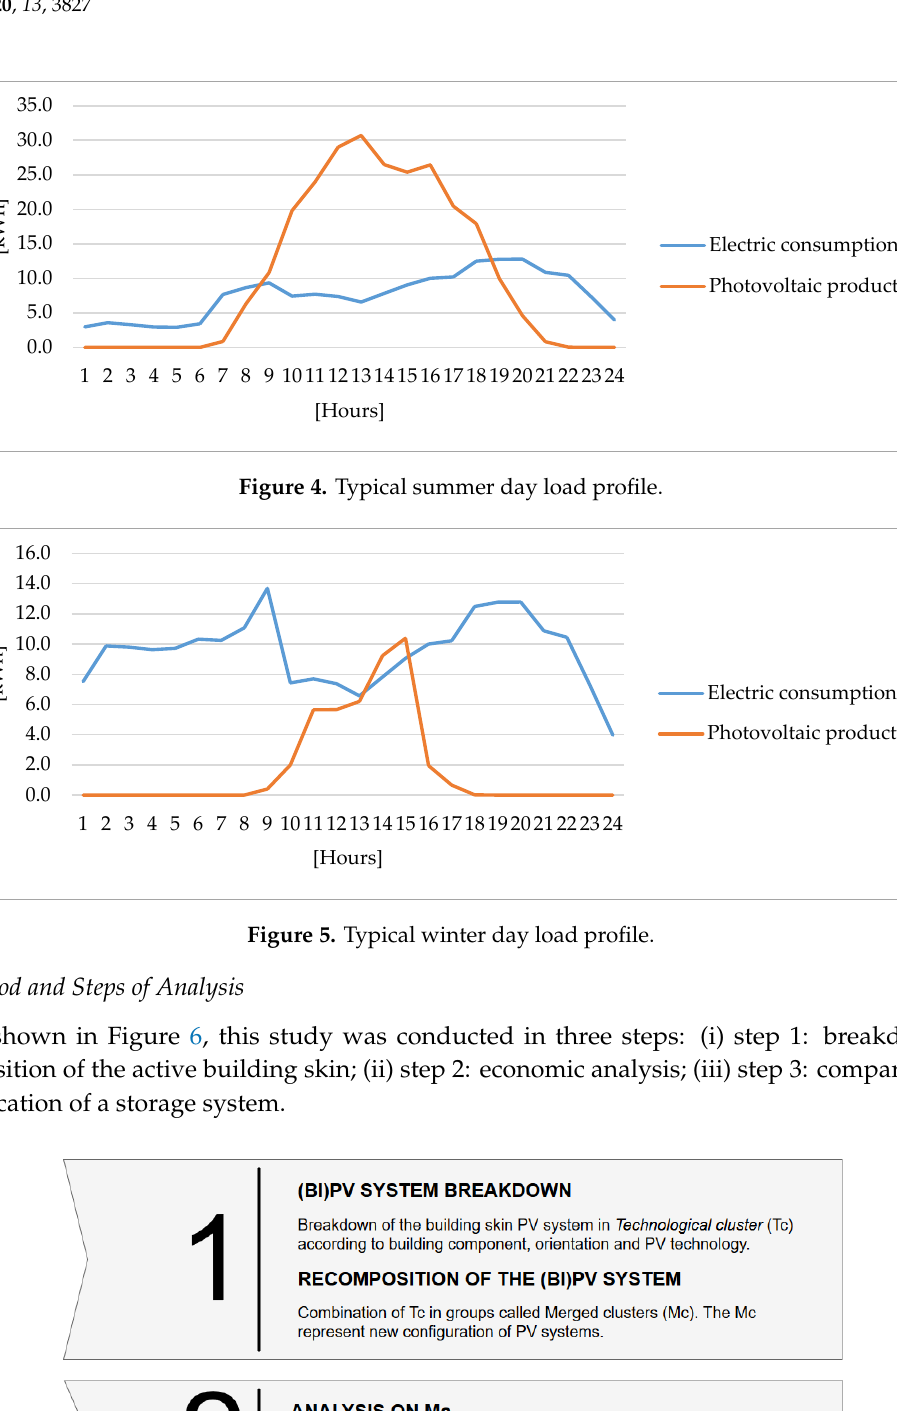
Figure 7. Schematic façade breakdown according with building component, orientation and PV technology. TC1 S façade aSi, TC2 S façade cSi, TC3 E façade aSi, TC4 W façade aSi, TC5 N façade aSi, TC6 E balcony cSi, TC7 W balcony cSi, TC8 Garage cSi, TC9 Roof cSi, TC10 Tracker cSi. TCs were combined with each other in order to recompose groups of PV elements, called merged clusters ( MC ). MCs represented new configuration of PV systems thanks to a combination of different building skin parts, as shown in Table 2, so that it was possible to analyze a range of different solutions. MC1 was a union of each TC ; it represented the actual state (all PV plants). The retribution of the MC1 did not represent the current state of the building (see MC10 ). MC2 was composed of only façade BIPV systems without roofs, railing applications and without the north oriented facade. MC3 stood for the BIPV solution with all four facades, namely MC2 including the northern facade. MC4 represented a combination of BIPV and roof BAPV systems; it was composed of BIPV modules on the four façades in addition to PV panels on the roof and the garage. MC5 stood for a conventional rooftop PV installation. MC6 was composed of only the PV modules with a final yield higher than 400 kWh/kWp (e.g., thus excluding some portions of facades non optimally exposed). MC7 considered BIPV on facades (apart from a-Si part installed on the south façade and the north facade)